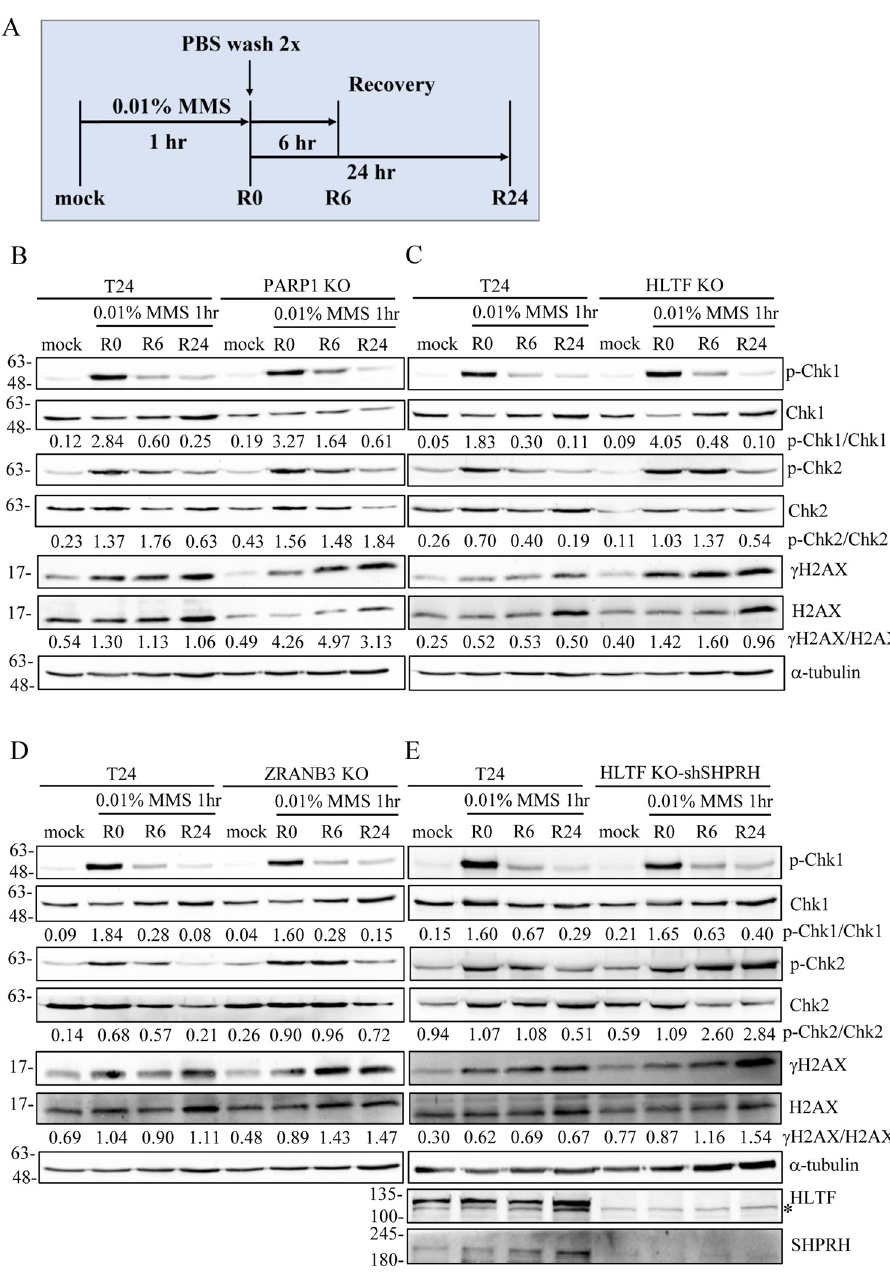
also revealed a similar trend with PARP1/HLTF showing the most PLA foci among the DNA translocases. Since DNase I or EtBr treatment did not disrupt these interactions, it suggests these interactions are not mediated through DNA. Interestingly, MMS or UV treatment increases PARP1/DNA translocase PLA foci. Using SIRF assay, we also found that MMS or